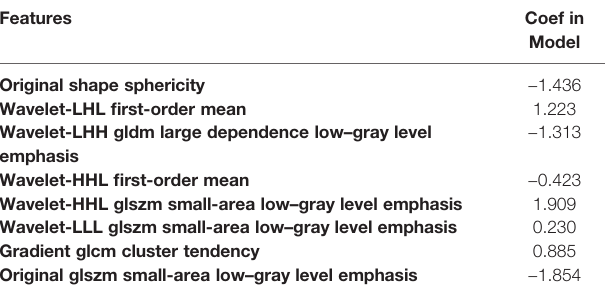
TABLE 4 | The coef fi cients of features in the model.